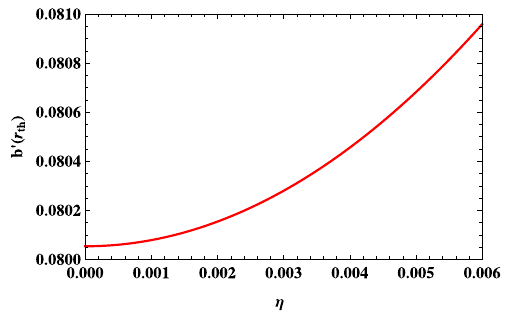
Fig. 5 b (cid:2) ( r th ) is plotted with respect to η corresponding to the parame- ters ρ 0 = 0 . 004 kpc − 2 , α = 0 . 5 , β = 0 . 8 , r th = 1 kpc and r 0 = 2 kpc